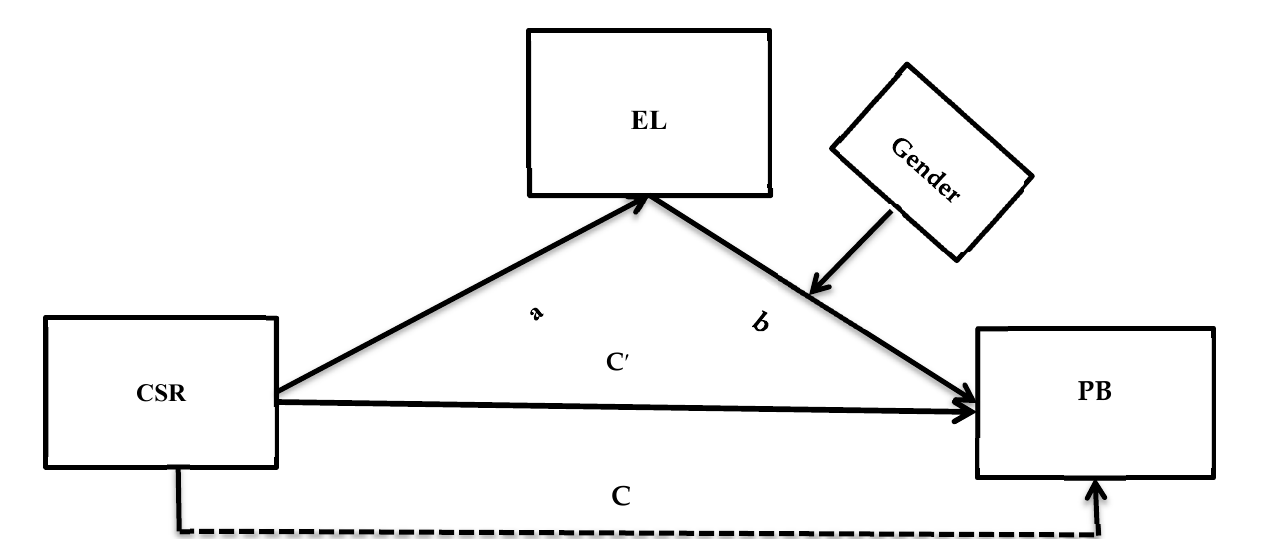
Figure 1. Hypothesized framework of the current study. CSR (X) = the independent variable, pro ‐ environmental behavior ― PB (Y) = the dependent variable, ethical leadership ― EL (M) = the mediating variable, Gender = moderating variable, C ′ = direct effect of X on Y in the presence of mediator, C = direct effect of X on Y without mediator. a and b represent the slope.